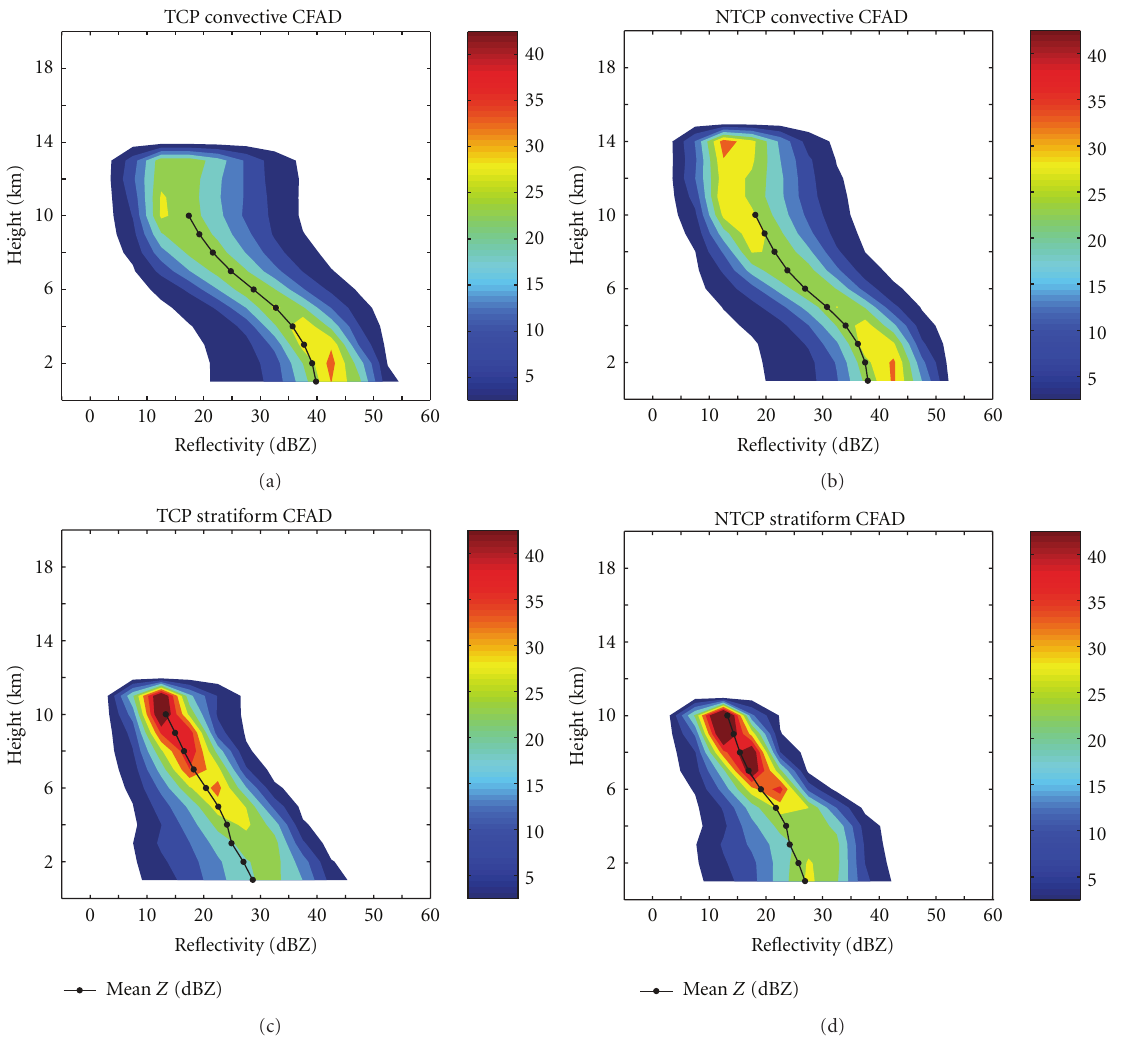
Figure 13: Mean CFADs for periods of most intense convection shown as (a) convective regime for the mean TCP event, (b) convective regime for the mean NTCP event, (c) stratiform regime for the mean TCP event, and (d) stratiform regime for the mean NTCP event. The CFADs are contoured every 5% from 2.5–42.5%. Mean reflectivity values throughout the event at each height up to 10km are shown as